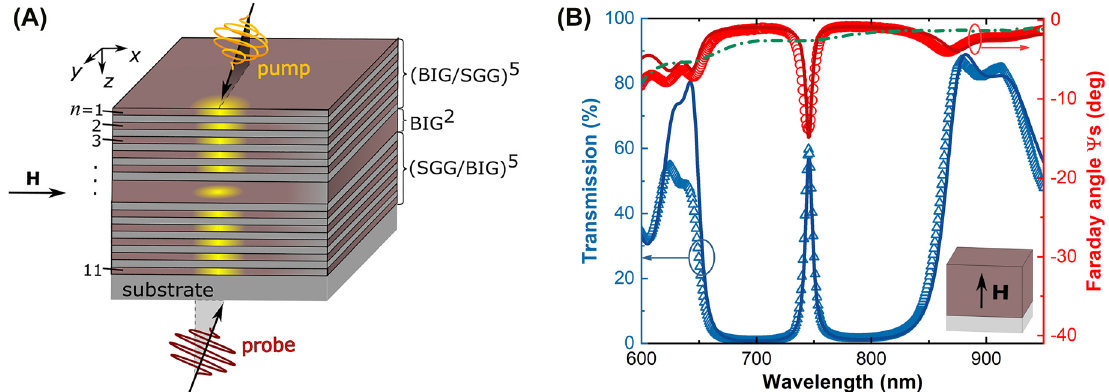
Figure 1: The schematic of the MPC sample and it spectra of transmittance and Faraday angle. (A) Scheme of the excitation and detection of magnetization precession in a magneto-photonic crystal. The magnetic film is 140 nm thick and is sandwiched between two magnetic Bragg mirrors composed of 5 pairs of magnetic dielectric layers BIG (70 nm, shown in brown) and nonmagnetic dielectric layers SGG (96 nm, shown in gray). The total thickness of the structure is 1.8 μ m. The circularly polarized pump excites the structure, and the linearly polarized probe is used to observe the magnetization dynamics at variable time delays. The symbol n denotes the serial number of the magnetic layer in the structure. (B) Magneto-optical characterization of the MPC in the out-of-plane external magnetic field. Experimental (circles and triangles) and calculated (solid lines) optical transmittance and the Faraday rotation spectra for the TM-polarized light at the angle of incidence 17 deg and the MPC fully magnetized out-of-plane at 2.0 kOe (see inset). The measured Faraday rotation spectrum for a single 700 nm thick BIG film on the substrate is shown by the green dash-dot line.